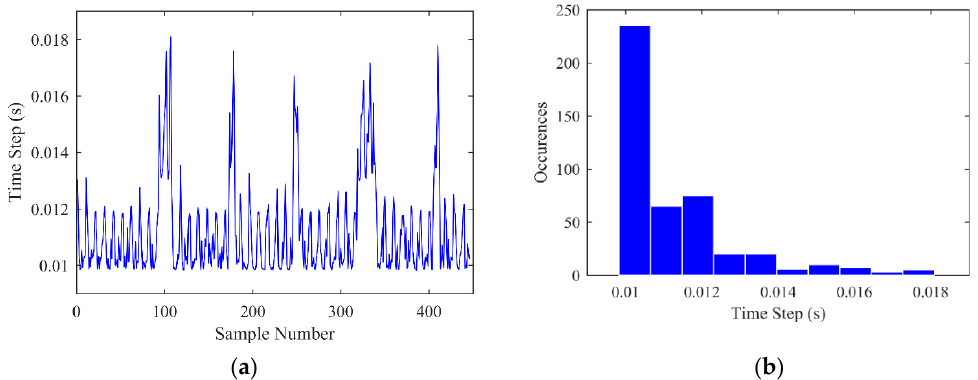
Figure 12. Characteristic sampling times for 5 s of IoT data: ( a ) time history; and ( b ) histogram.